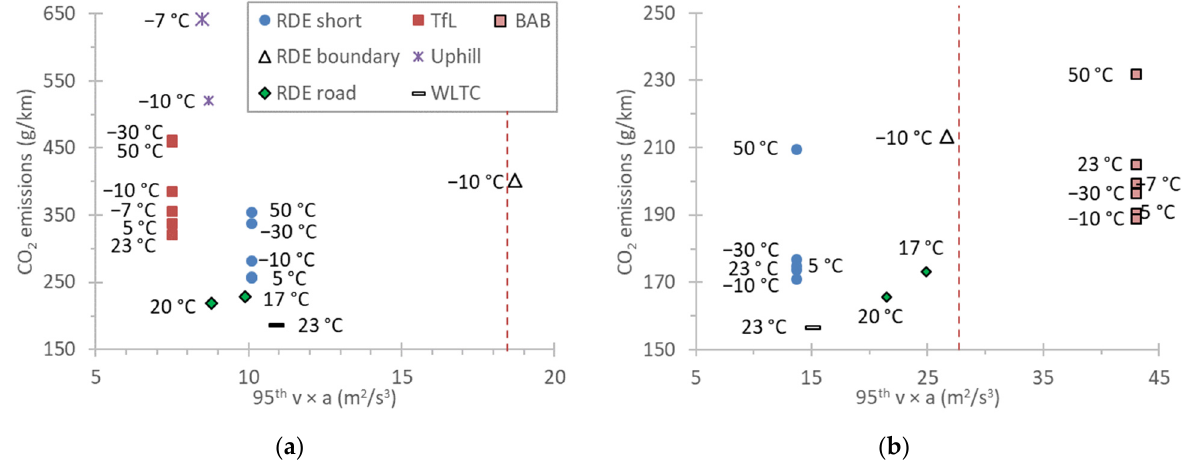
Figure 5. CO 2 emissions in function of 95th percentile of speed times acceleration (v × a): ( a ) urban cycles (TfL, uphill) or urban parts of the rest cycles (RDE short, RDE boundary, RDE road, and WLTC low and medium phases); ( b ) motorway cycle (BAB) or motorway parts of the rest cycles (RDE short, RDE boundary, RDE road, and WLTC extra high phase). The dashed line presents the approximate limit from the RDE regulation. The ambient temperature of each test is indicated next to each test.